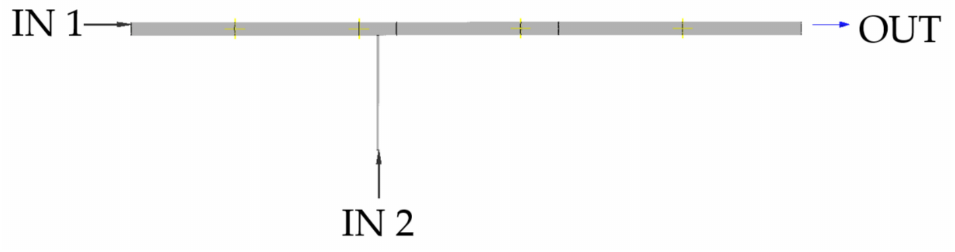
Figure 4. Determining the position of inputs (IN1, IN2) and output